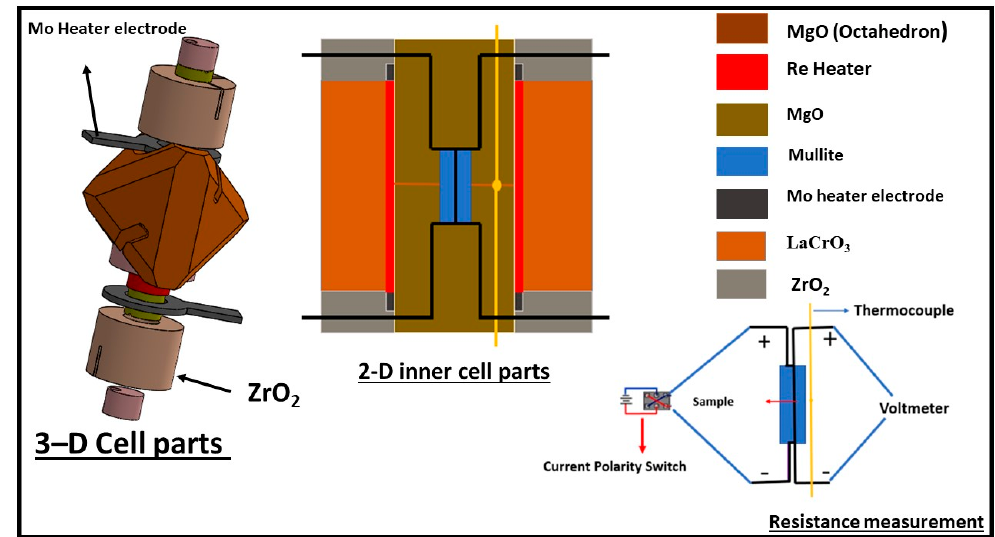
Figure 1. The 3D SolidWork sketch of the pressure cell assembly and the 2D sketch of the inner parts of the assembly alongside the resistance measurement setup. Modified from Ezenwa and Yoshino 2020a [19].